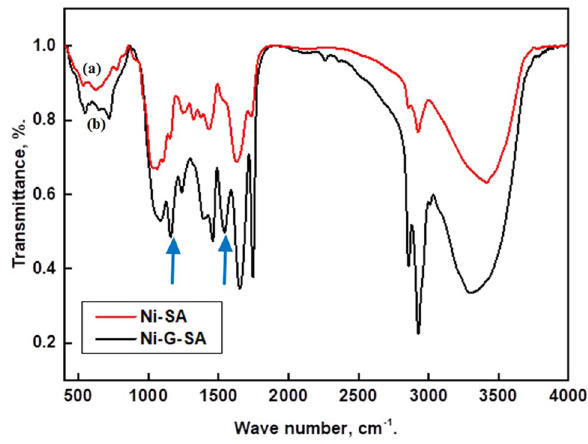
Figure 2. FTIR spectra of steel coated by ( a ) Ni-SA coating and ( b ) Ni-G-SA